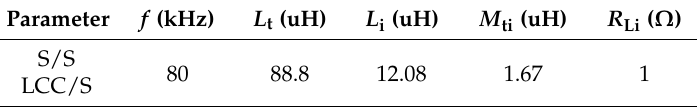
Table 1. Initial parameters used in the multi-load WPT systems.